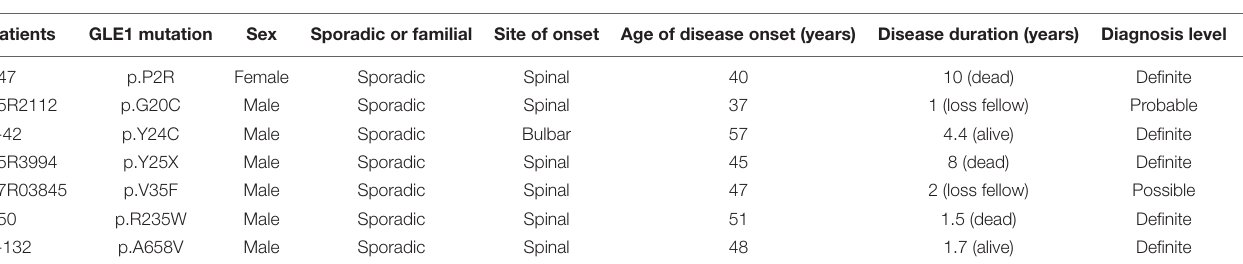
TABLE 3 | Clinical characteristics of GLE1 mutation